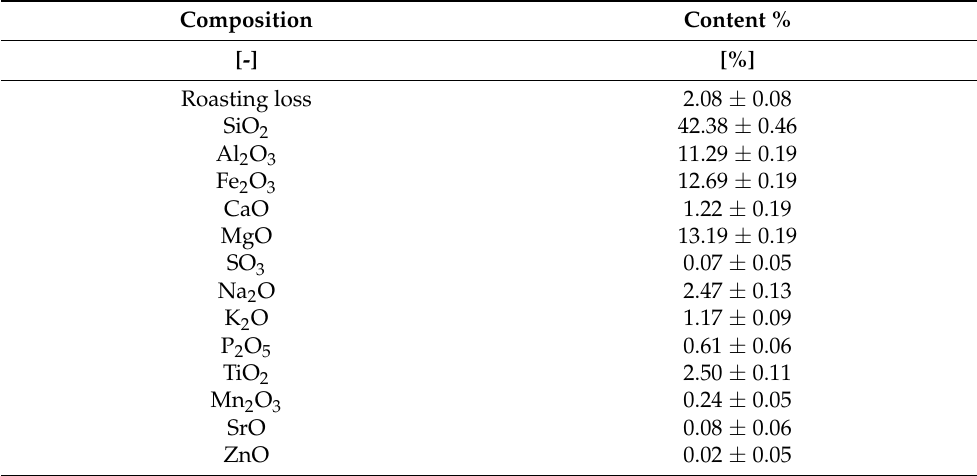
Figure 3. Basalt dust (photo by K. Se ń czuk). Table 1. Basalt A chemical composition.